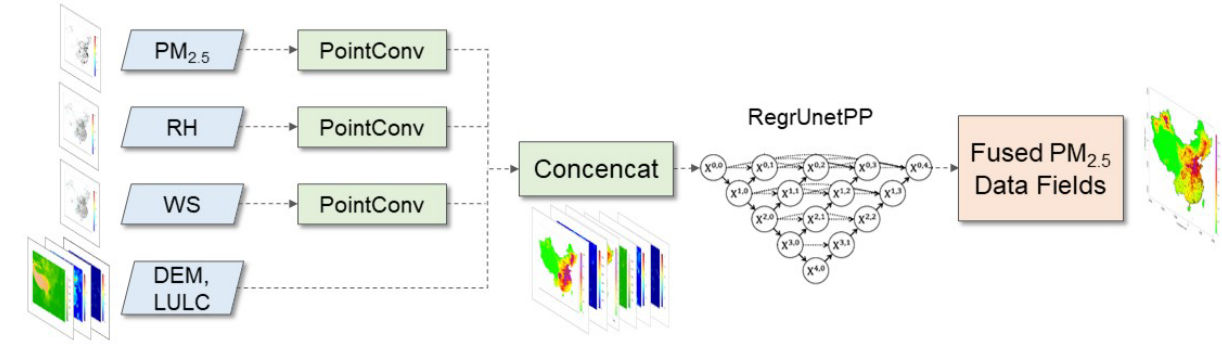
Figure 2. Data fusion framework using station observations of multiple variables to obtain gridded fields of PM 2 . 5 .